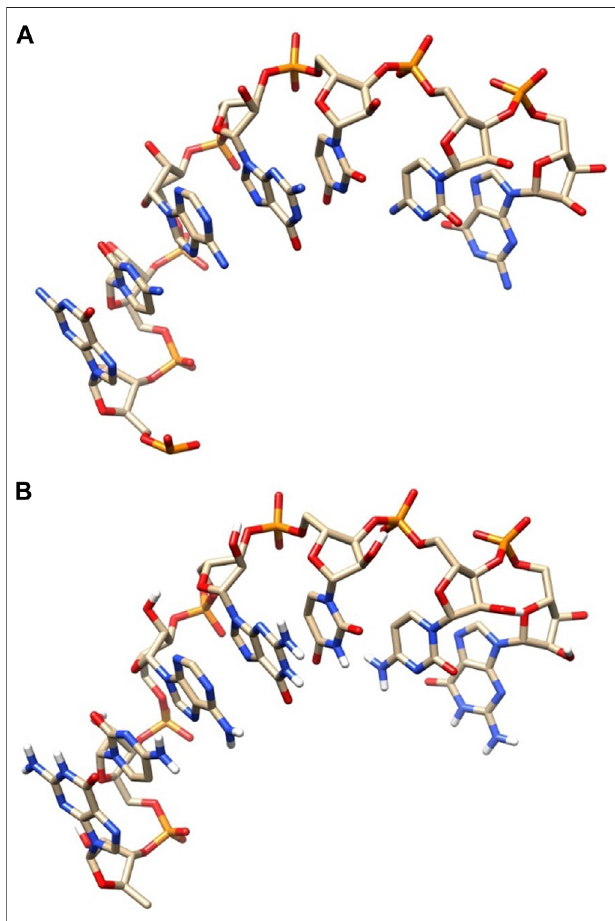
FIGURE 6 | Comparative diagram of the native structure and predicted structure. (A) Native structure. (B) Predicted structure.